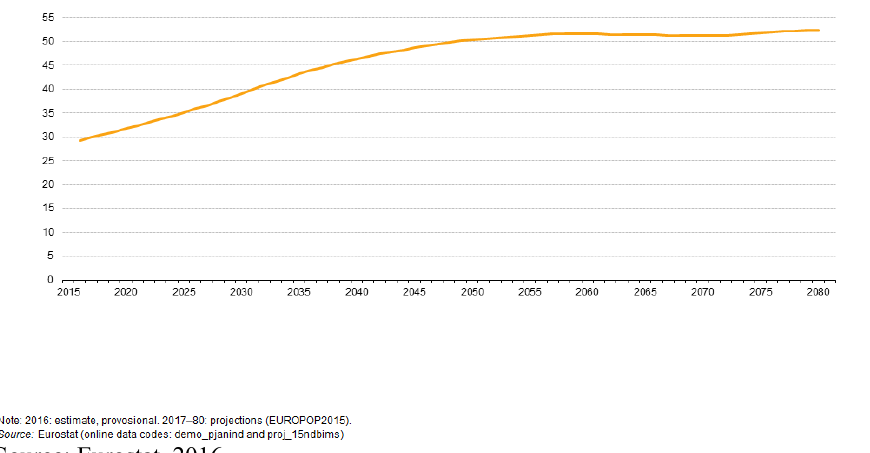
Source: Eurostat,